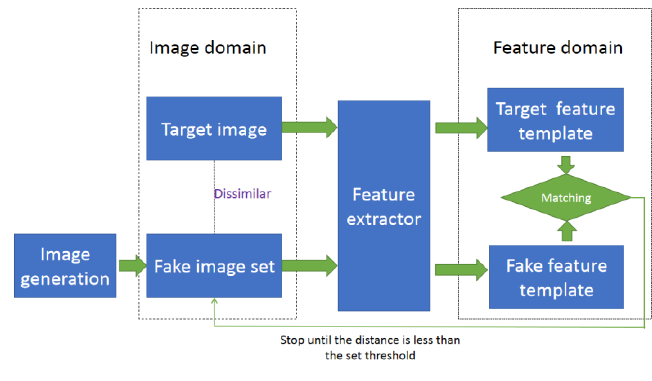
Figure 3. False acceptance attack.